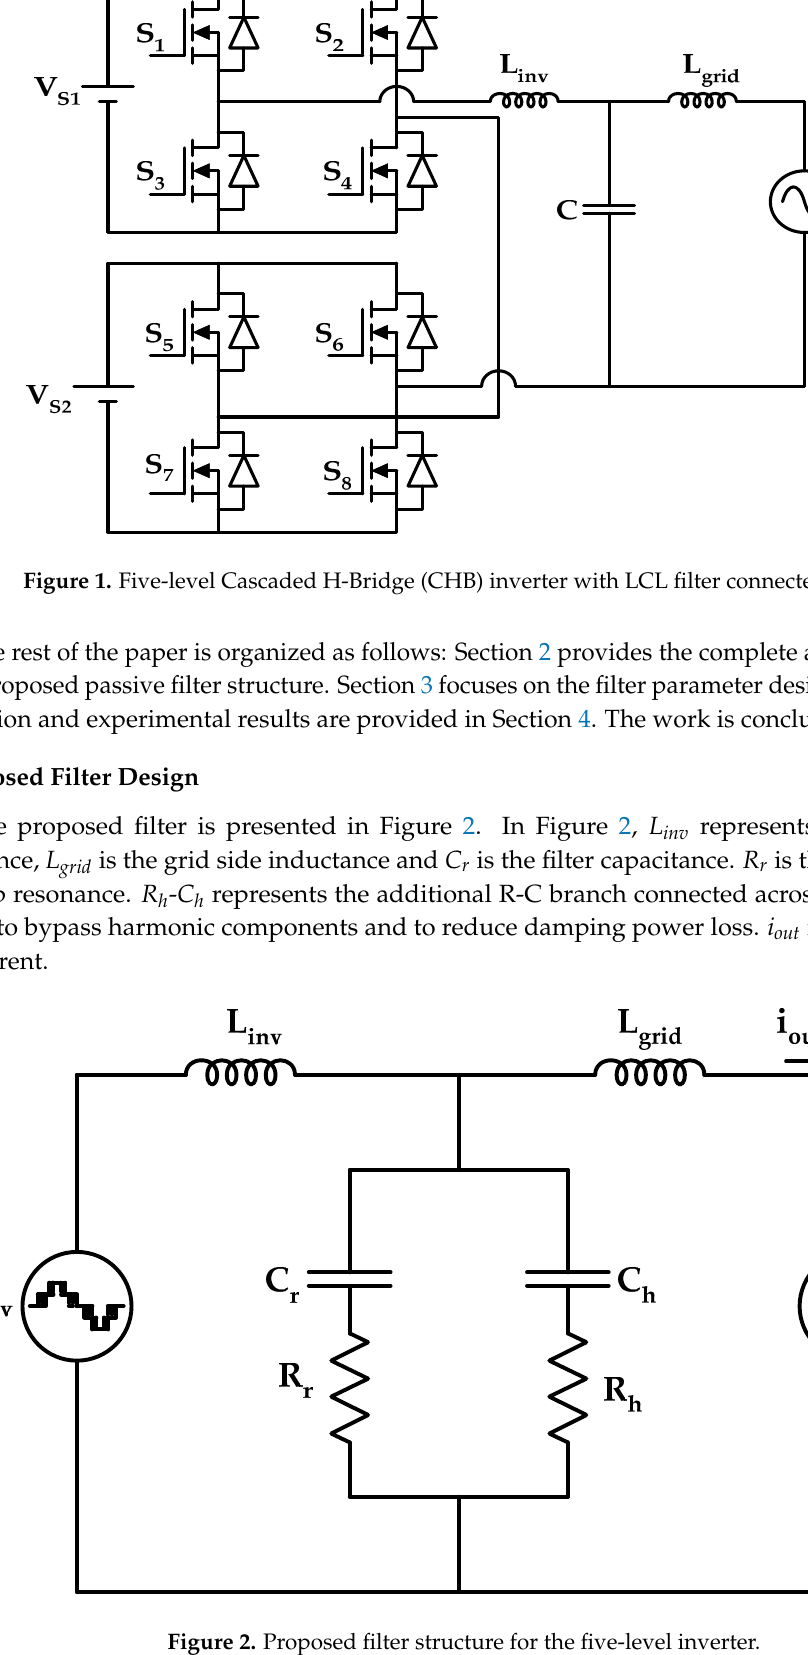
Figure 2. Proposed filter structure for the five-level inverter.